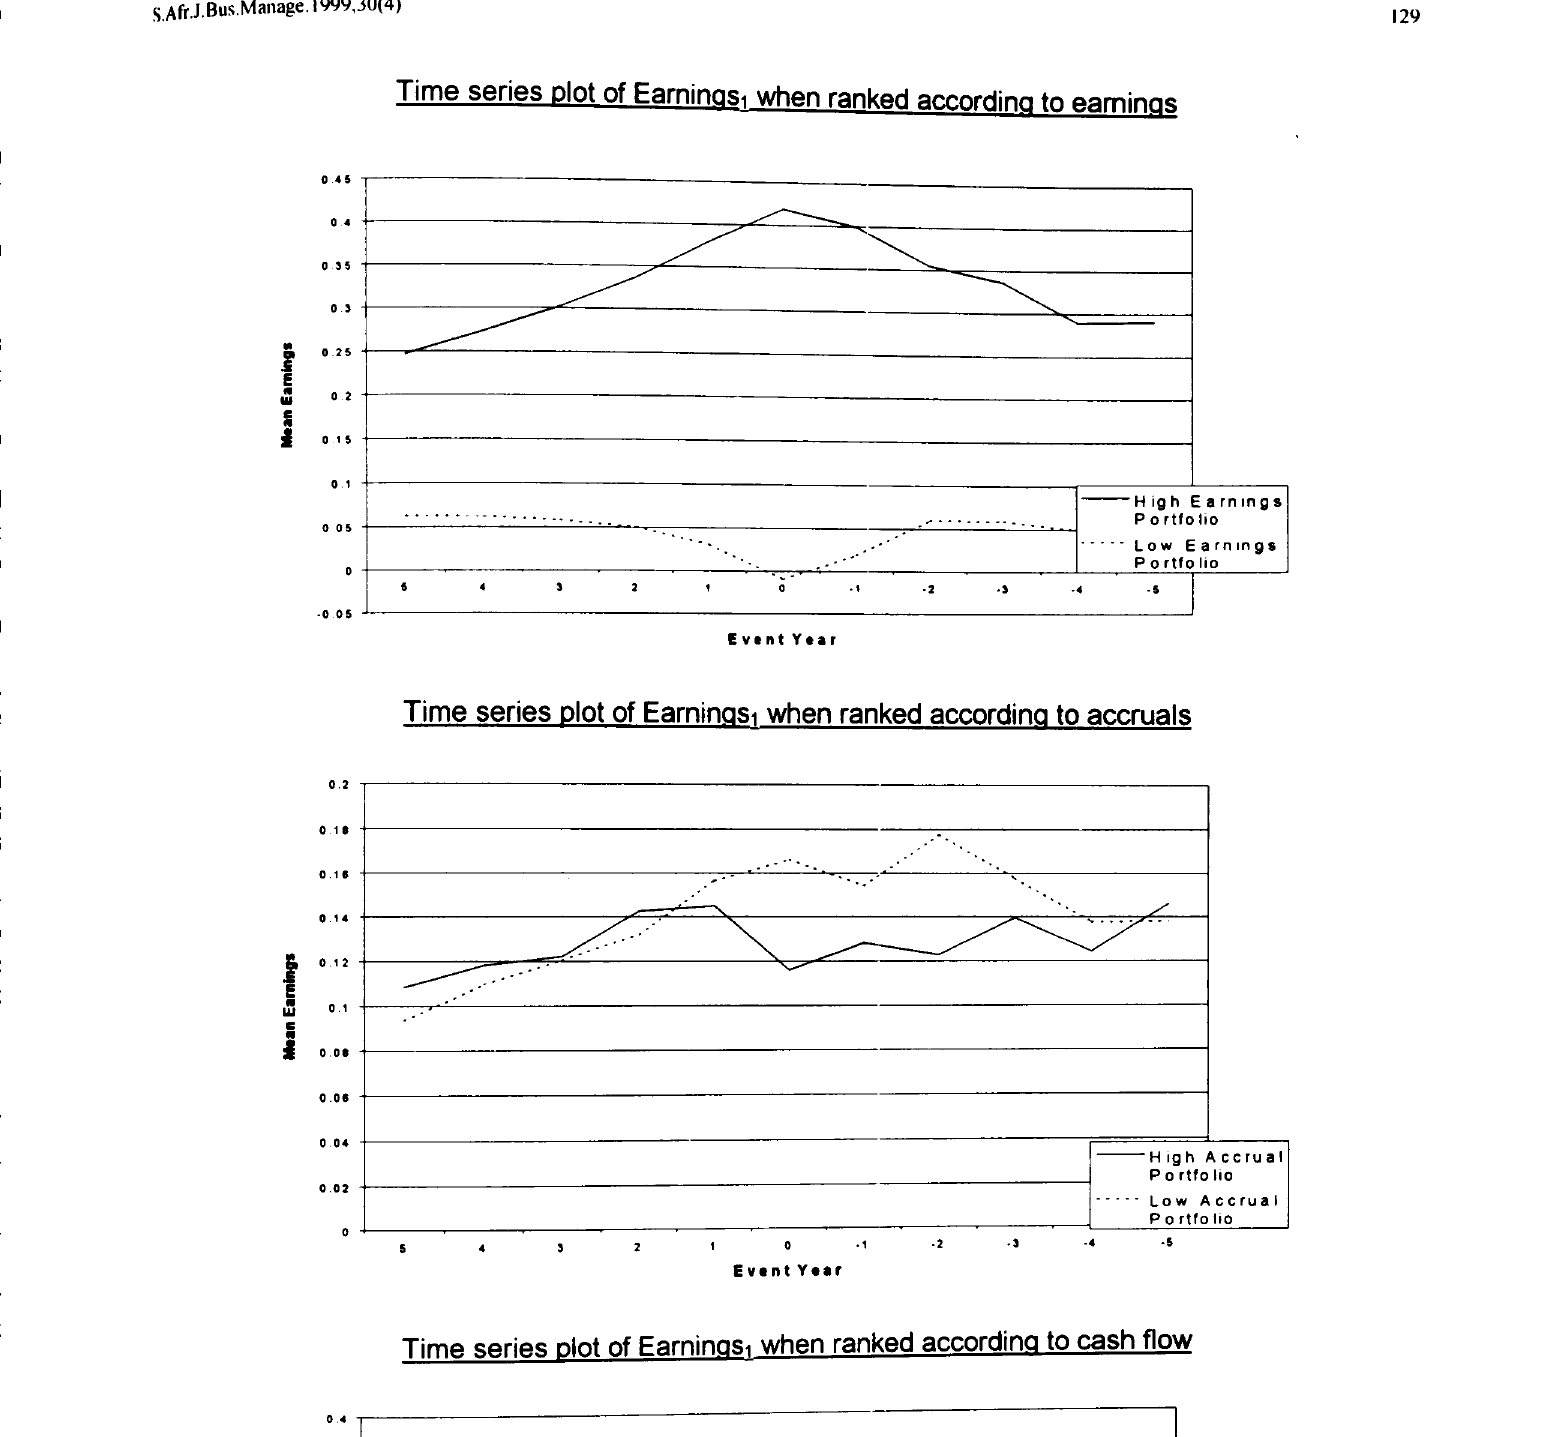
Figure I Time series properties of earnings in extreme portfolios, when ranked according to Eamingsi, accruals and cash flow